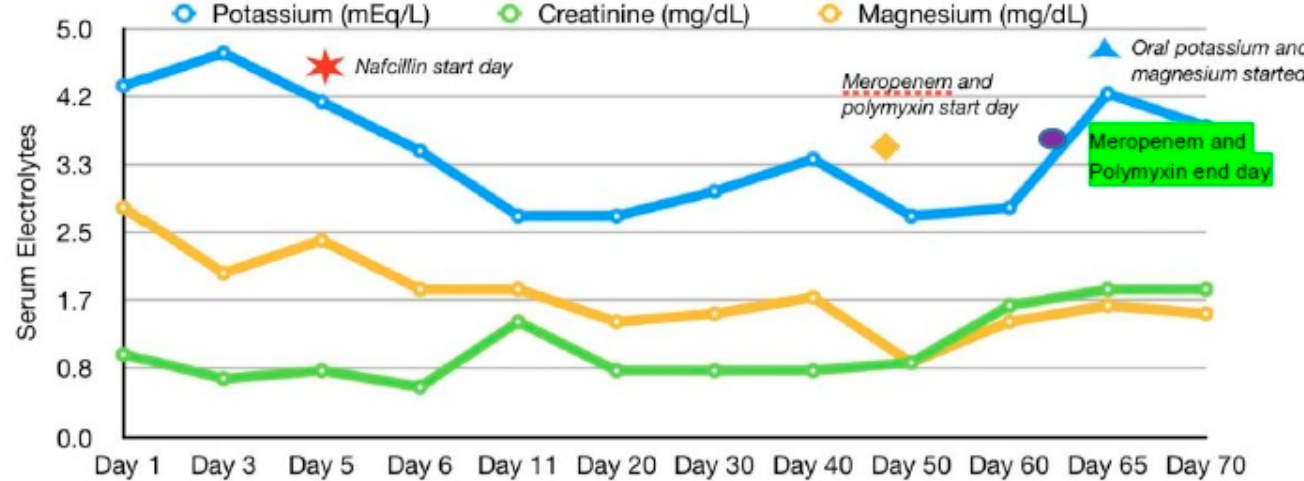
Figure 1. Electrolyte trends.